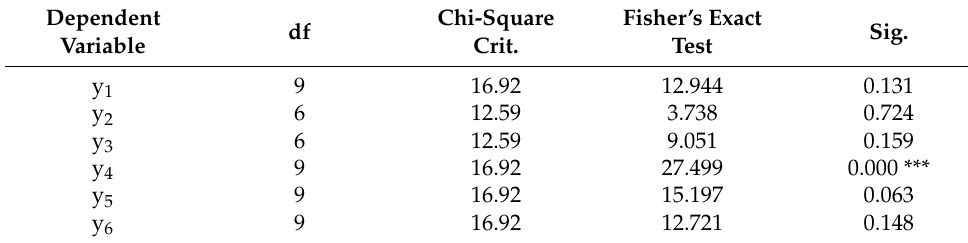
Table 4. Fisher’s exact test values depending on the six sigma duration, data for whole sample. Dependent Chi-Square Fisher’s Exact df Sig. Variable Crit. Test y 1 9 16.92 12.944 0.131 y 2